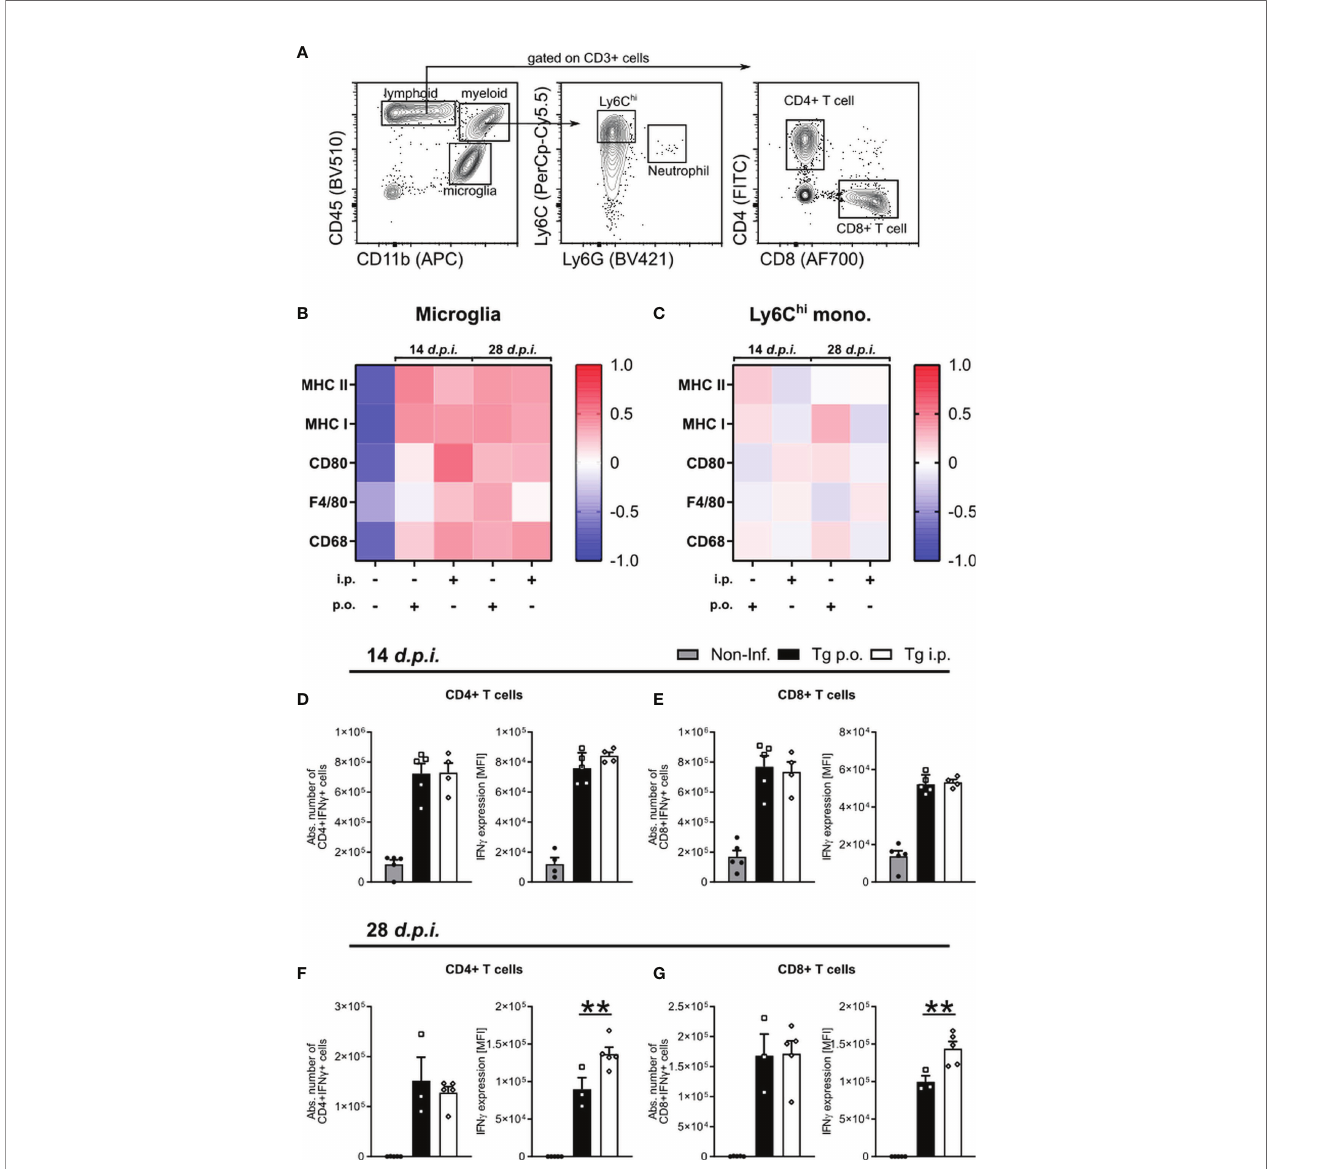
FIGURE 5 | The development of neuroin fl ammation in p.o. vs. i.p. infected mice. Immune cells were isolated from the brains of naïve (Non-Inf.) mice and mice after 14 and 28 d .p.i. (A) Representative gating strategy for resident and recruited immune cell populations in the brain (orally infected, 14 d .p.i. brain shown). Following viability staining and the basic FSC/SSC gating, viable single cells were separated by their expression CD45 and CD11b. CD11b + CD45 int microglia, CD11b + CD45 hi Ly6G - Ly6C hi in fl ammatory monocytes, CD11b - CD45 + CD3 + -CD4 + and -CD8 + T cells were identi fi ed. (B, C) Heat map plots of the relative surface expression of MHC II, MHC I, CD80, F4/80, and CD68 in naïve, p.o. and i.p. infected mice at days 14 and 28 p.i. For (B) microglia and (C) Ly6C hi in fl ammatory monocytes, the median fl uorescence intensities (MFI) of each marker were normalized to the overall mean for each respective marker. The quanti fi cation of splenic IFN g production by CD4 + and CD8 + T cells in mice infected at (D, E) 7 and (F, G) 14 d .p.i. The absolute number of IFN g + T cells was calculated as a portion of the total living cells. IFN g expression levels were quanti fi ed by the MFI expression of the respective fl uorochrome. Positive expression was determined by a matched isotype control. Symbols represent individual animals; columns represent means and error bars represent + SEM. A one-way ANOVA followed by Tukey ’ s correction for multiple comparisons